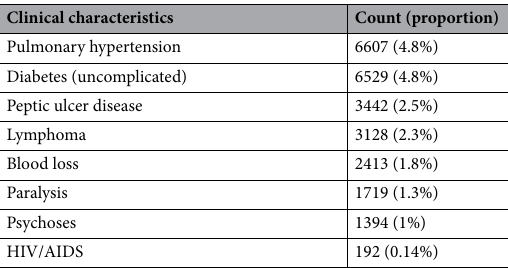
Table 1. General characteristics of study population. Descriptive statistics for the study population, including: County-level COVID-19 incidence and testing rates, demographics (age, gender, race, ethnicity), vaccine counts, and Elixhauser comorbidities.